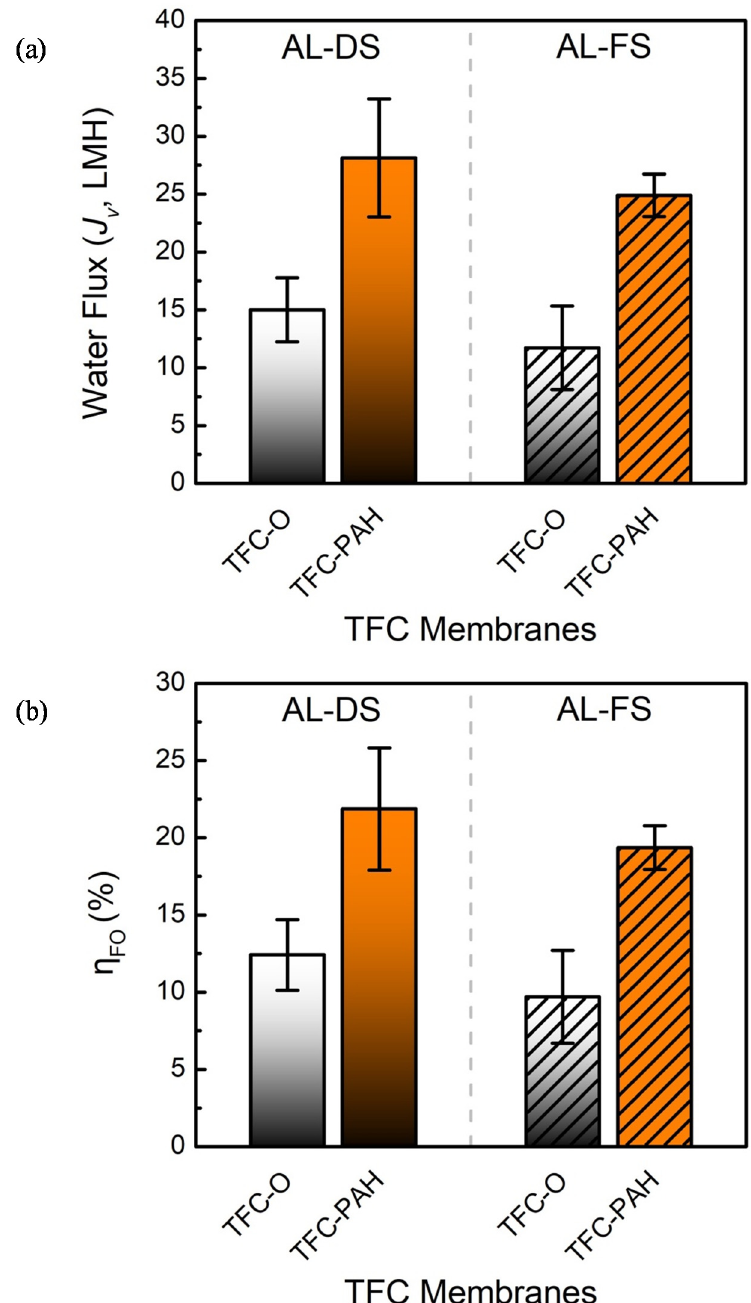
Figure 12. Comparison of the FO performance of the TFC membranes with the PAN-O substrate and the PAN-A substrate modified with the deposition of PAH: ( a ) the water flux and ( b ) the FO e ffi ciency (i.e., the ratio of the measured water flux to that for the case ignoring any concentration polarization). An aqueous solution of 2 M NaCl solution was employed as the draw solution, whereas the feed solution was Milli-Q water; the active layer (i.e., the IP layer) was exposed to the feed solution (i.e., the orientation of AL-FS) or the draw solution (i.e., the orientation of AL-DS). The error bars correspond to the standard deviations of the three independent measurements.